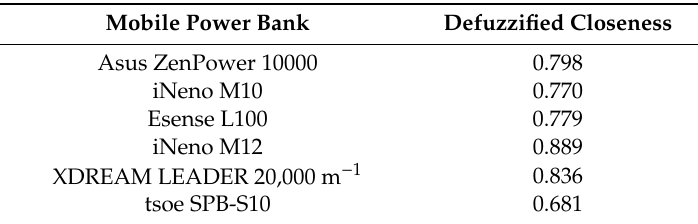
Table 9. Defuzzification results.